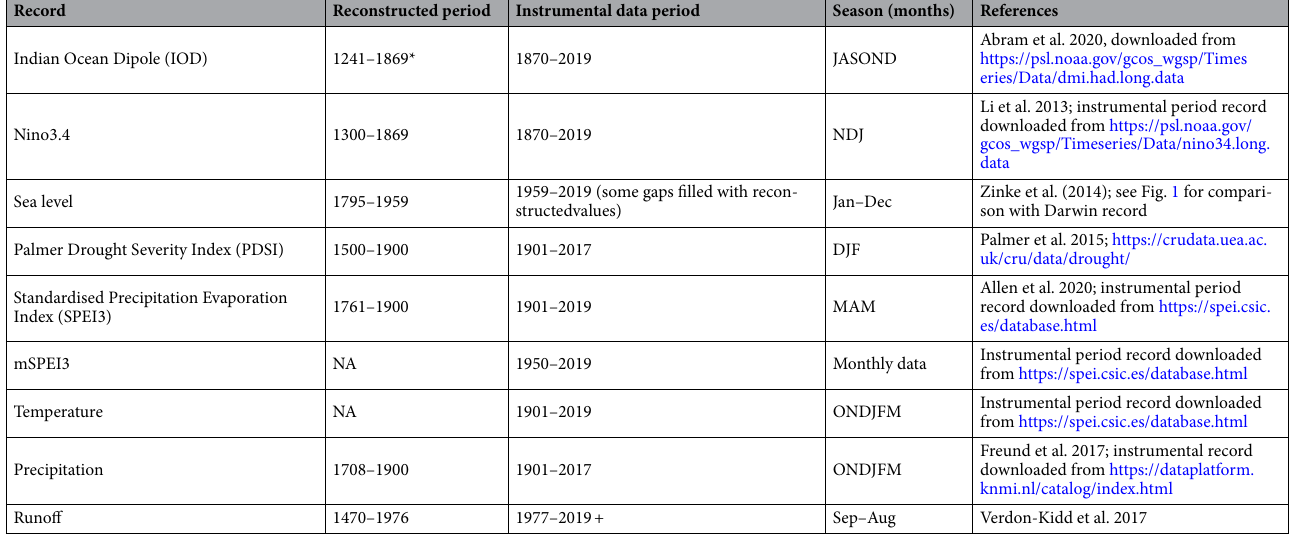
Table 1. Data used. *Reconstruction does not cover entire period. + Simulated runoff based on precipitation at Oenpelli. No regionally specific high-resolution temperature reconstruction is